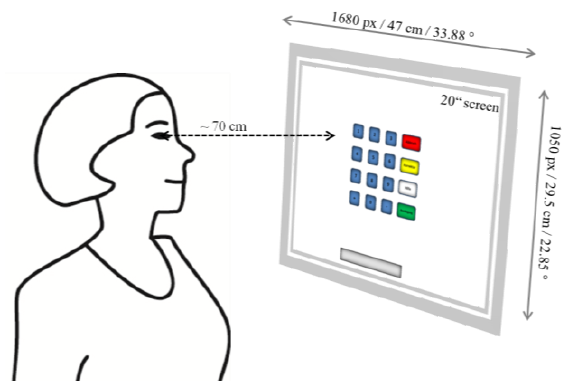
Figure 2. Setup of experiment